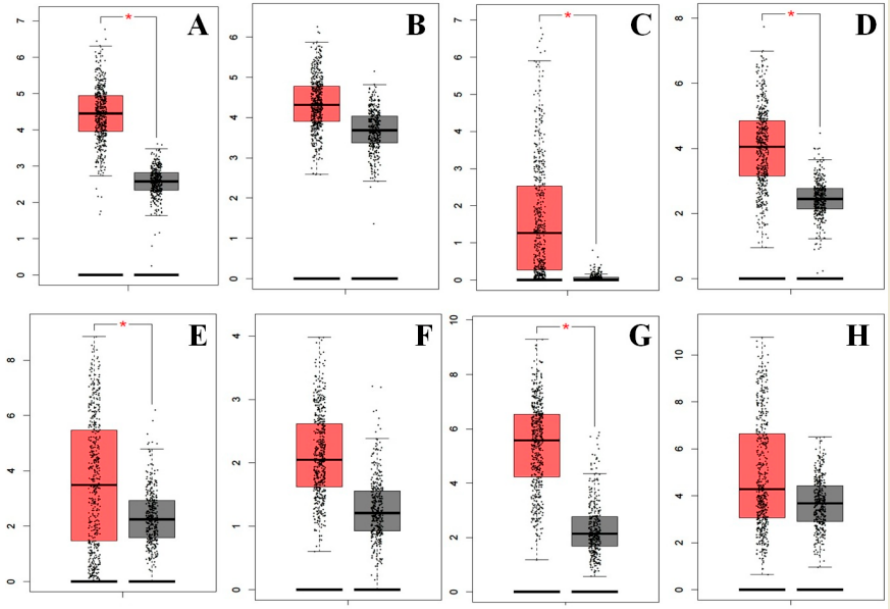
Figure 6. Expression of potential target genes in lung adenocarcinoma (LUAD) and control samples from the Gene Expression Profiling Interactive Analysis (GEPIA) database. Expression of the potential target genes was detected in 483 LUAD tissues (red in color) and 347 normal tissues (black in color). Eight potential target genes ( A ) EFNA4, ( B ) NRAS, ( C ) PITX2, ( D ) RAC3, ( E ) TNNT1, ( F ) TRAIP, ( G ) UBE2C, and ( H ) UCHL1 were upregulated in LUAD tissues compared to control.